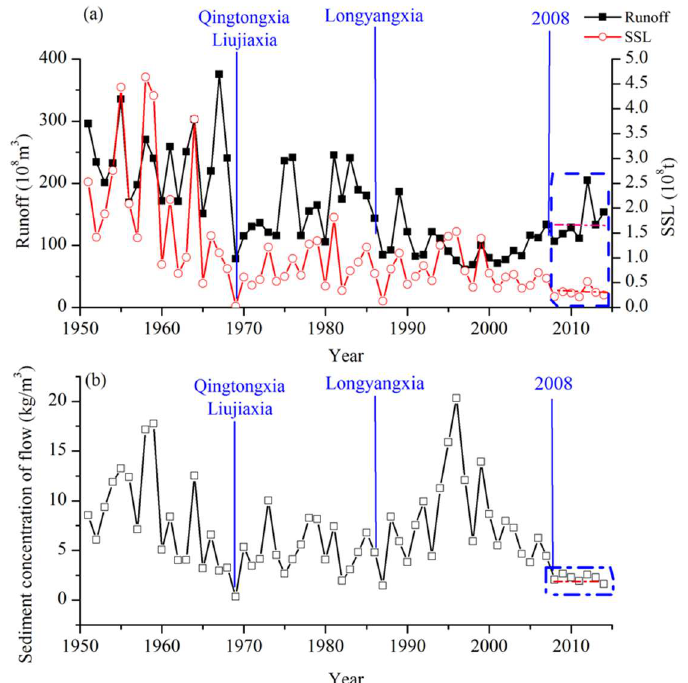
Figure 10. Variations in ( a ) the runoff and suspended sediment load (SSL), and ( b ) the sediment concentration, during the summer flooding seasons at the Qingtongxia station.